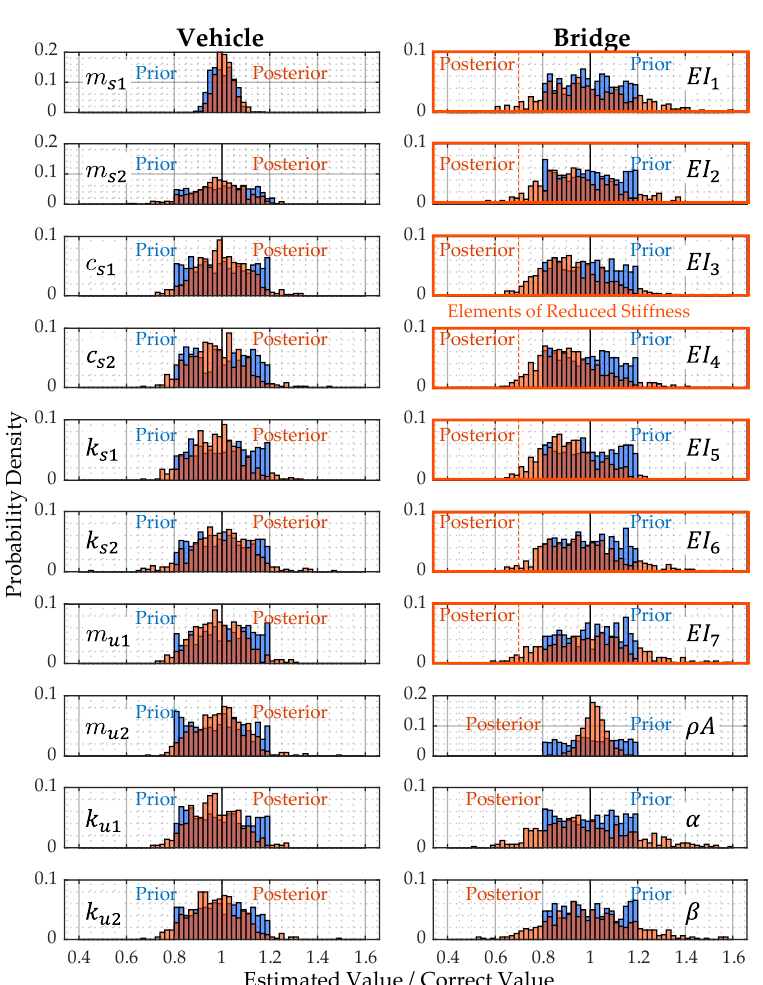
Figure A5. The application results of the PRE method in the case of Scenario 2 (stiffness decrease section: 0 ~ 𝐿 , decrease rate: 10%).